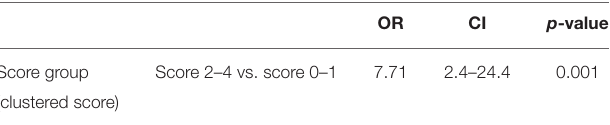
TABLE 6 | Univariate logistic regression evaluating our score outcomes predicting lymph node metastasis.